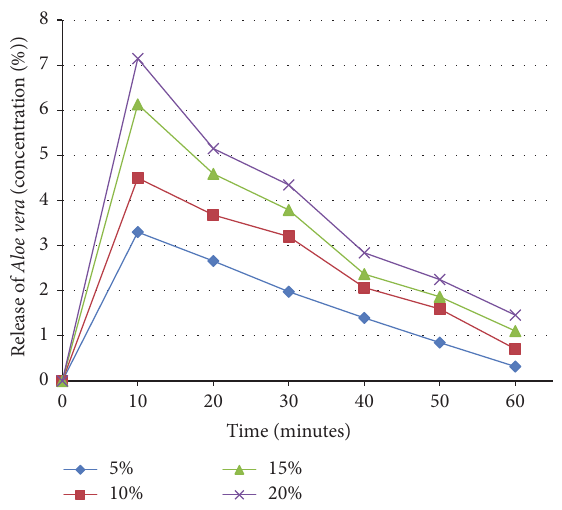
Figure 5: Aloe vera release profile of Aloe vera /polymer films with different concentrations. 𝑥 -axis shows time in minutes and 𝑦 -axis shows release of Aloe vera concentration in